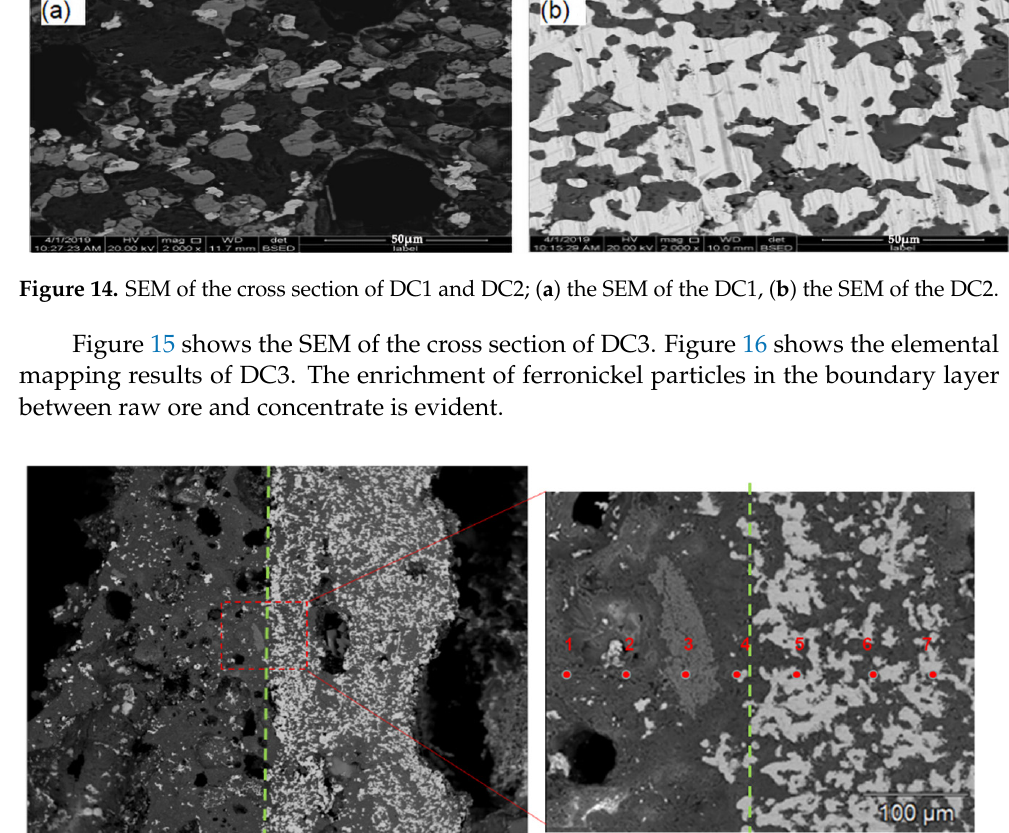
Figure 14. SEM of the cross section of DC1 and DC2; ( a ) the SEM of the DC1, ( b ) the SEM of the DC2.